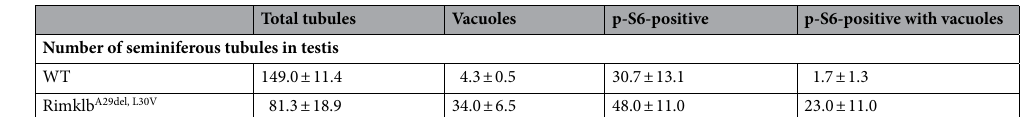
Table 1. The number of p-S6-positive seminiferous tubules with increased vacuoles in the Rimklb A29del, L30V mouse testis. The total number of tubules, tubules with vacuoles, p-S6-positive tubules, p-S6-positive tubules with vacuoles in WT and Rimklb A29del, L30V mouse testis at 12 weeks of age. Data are presented as mean ± SD.